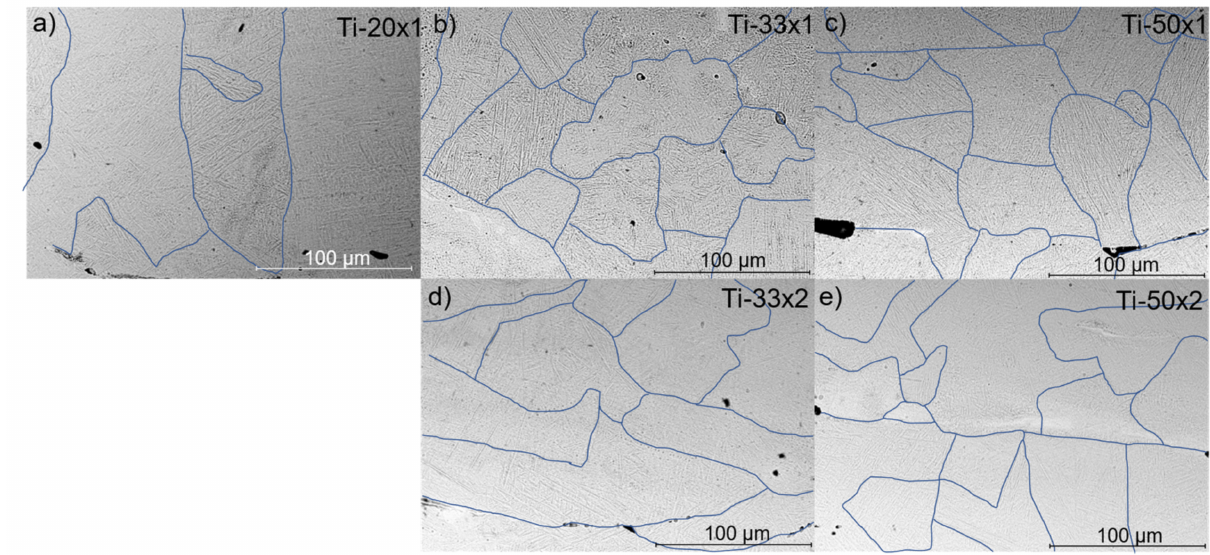
Figure 9. Microstructure of the different specimens tested as observed by SEM: ( a ) Ti-20 × 1; ( b ) Ti-33 × 1; ( c ) Ti-33 × 2; ( d ) Ti-50 × 1; and ( e ) Ti-50 ×